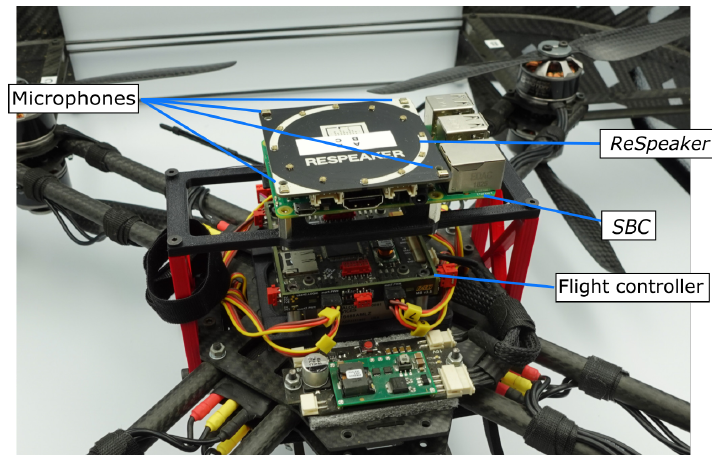
Figure 5. Experimental setup to acquire acoustic